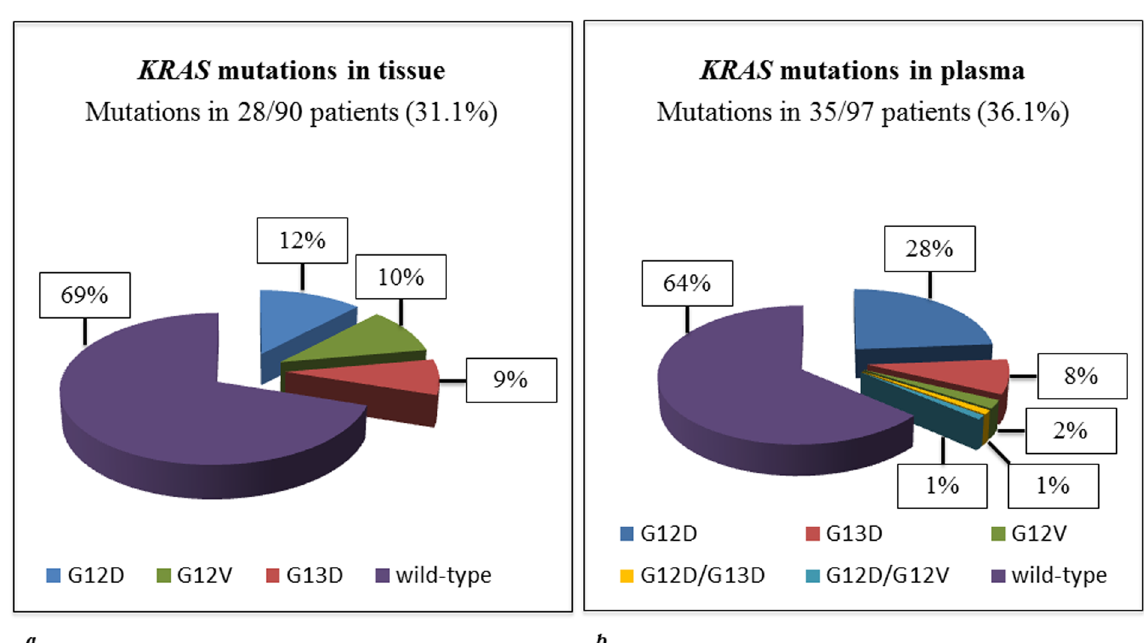
Figure 2. Frequency of the most frequently mutated KRAS hotspot mutation ( i.e ., G12D, G12V and G13D) in tissue ( a ) and plasma ( b ) of patients who were assessable for the analysis of circulating tumour DNA (tissue KRAS status was unknown for 7/97